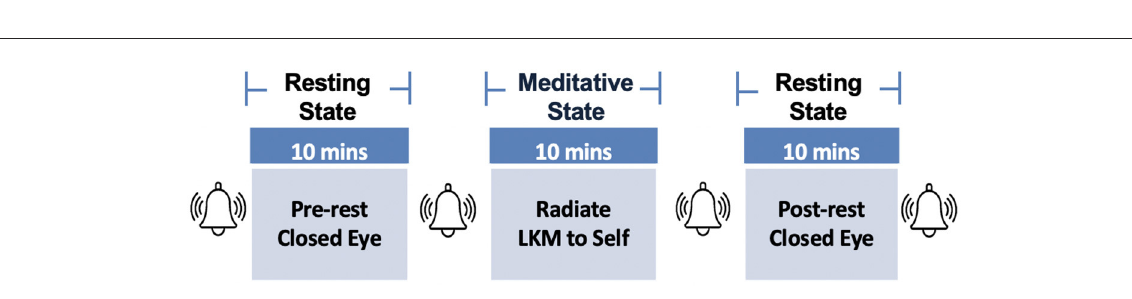
cleaned of artifacts. Major artifacts including head